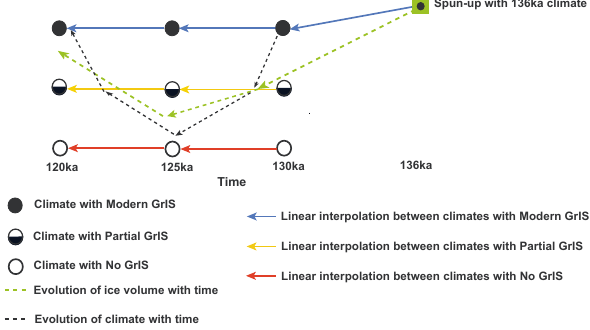
Fig. 4. Illustration of the coupling methodology between climate and ice sheet for the LIG. Simulations are run for a total of 16000 model years, initiated with a climate representative of 136ka (GrIS included). The transient climate evolves simultaneously with the ice sheet model. The climate is linearly interpolated from 136 to 130ka. From 130 to 120ka the climate evolves (black dashed ar- row shows an example) according to a weighting towards either a transient climate where there is a modern-day GrIS (black filled cir- cles), one where there is a partial GrIS (black half-filled circles) and one where the GrIS is removed (black open circles). The weighting is based on the ratio of the previous years’ ice volume relative to the ice volume at 130ka. The green dashed arrow shows schematically the evolution of the ice sheet volume. See text for more details and